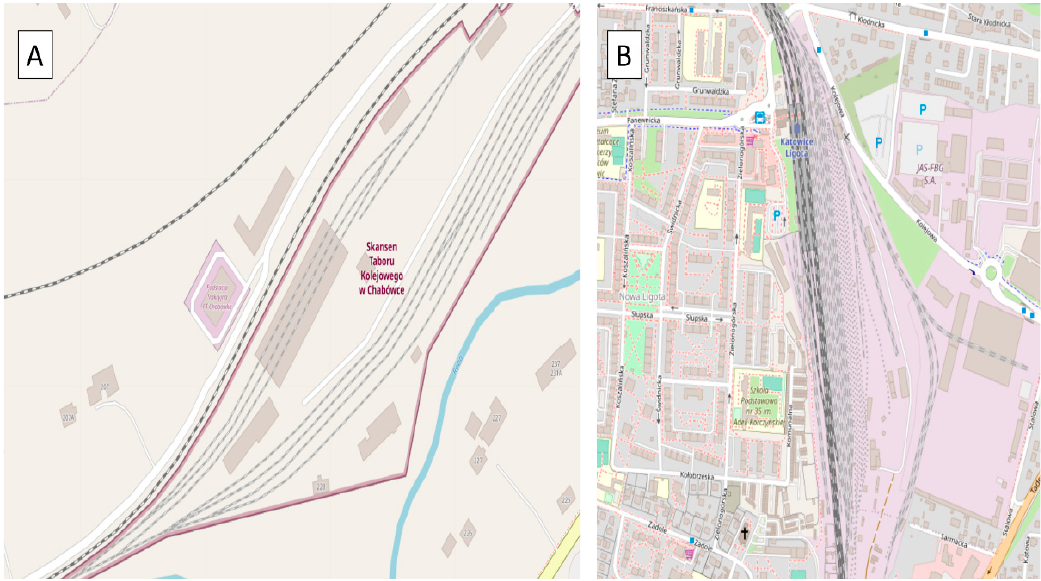
Figure 1. Site plans of the research stations where the measurement was conducted: ( A ) Chabówka, Poland; ( B ) Katowice Ligota, Poland. Source: OSM [50,51]. Figure 1A is a site plan of the Chab ó wka (Poland) station, i.e., the area where the studies in question were carried out, case 1 (49.595109 ◦ N, 19.926443 ◦ E). Figure 1B is a site plan of the Katowice Ligota (Poland) station, i.e., the area where the studies in question were carried out, case 2 (50.207551 ◦ N, 18.955843 ◦ E). In case 1, pilot studies were